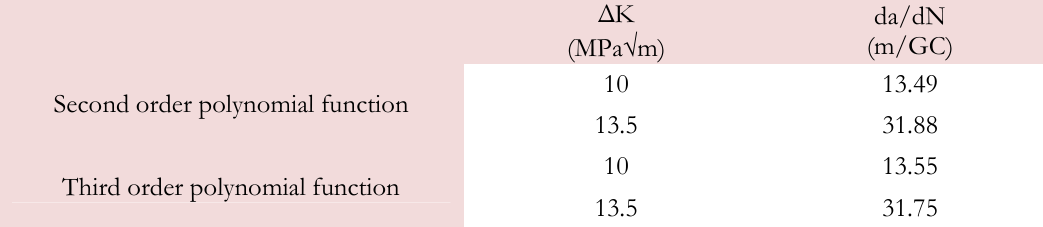
Table 3: Crack growth rate computed using the procedure I.